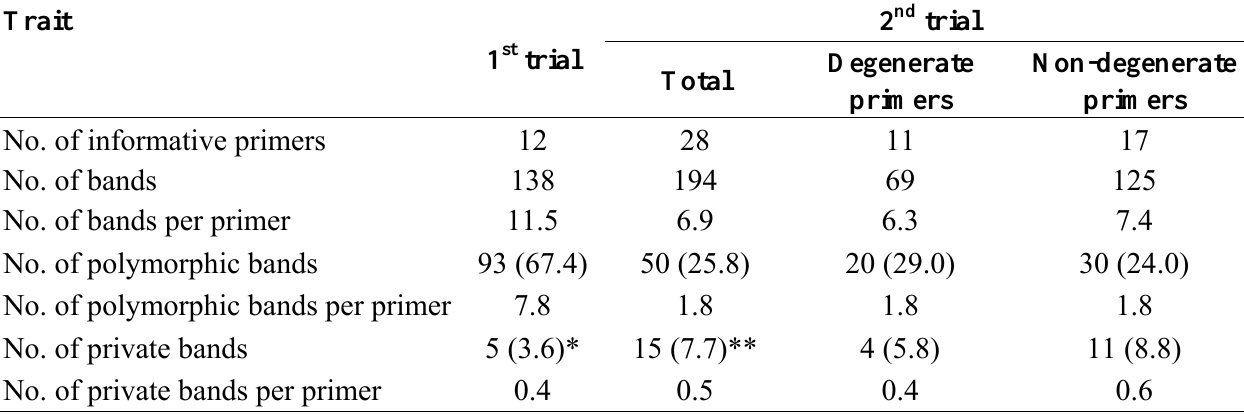
Table 2. Statistics of the molecular analyses carried out with ISSR markers in the preliminary trial (13 genotypes from 10 accessions of the two gene pools) and in the second trial (16 DNA bulks of four plants each, representing landraces belonging to the Andean gene pool from Southern Italy plus the cv Clio). Percentages are reported in